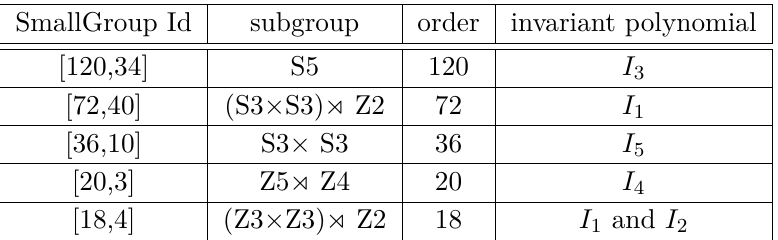
Table 3 . Irreducible subgroups of O(4) and the invariant polynomials